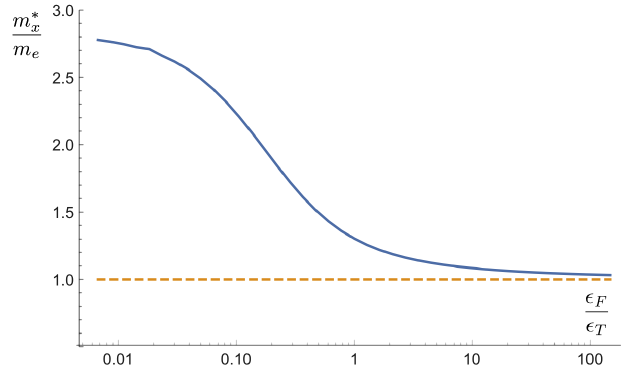
FIG. 2. Polaron mass as a function of Fermi energy. For this plot, we used a contact interaction model for exciton-electron interaction and solved the polaron problem using the non-self- consistent T-matrix approach developed in Ref. [23]. We took the exciton mass to be twice as large as the electron mass m